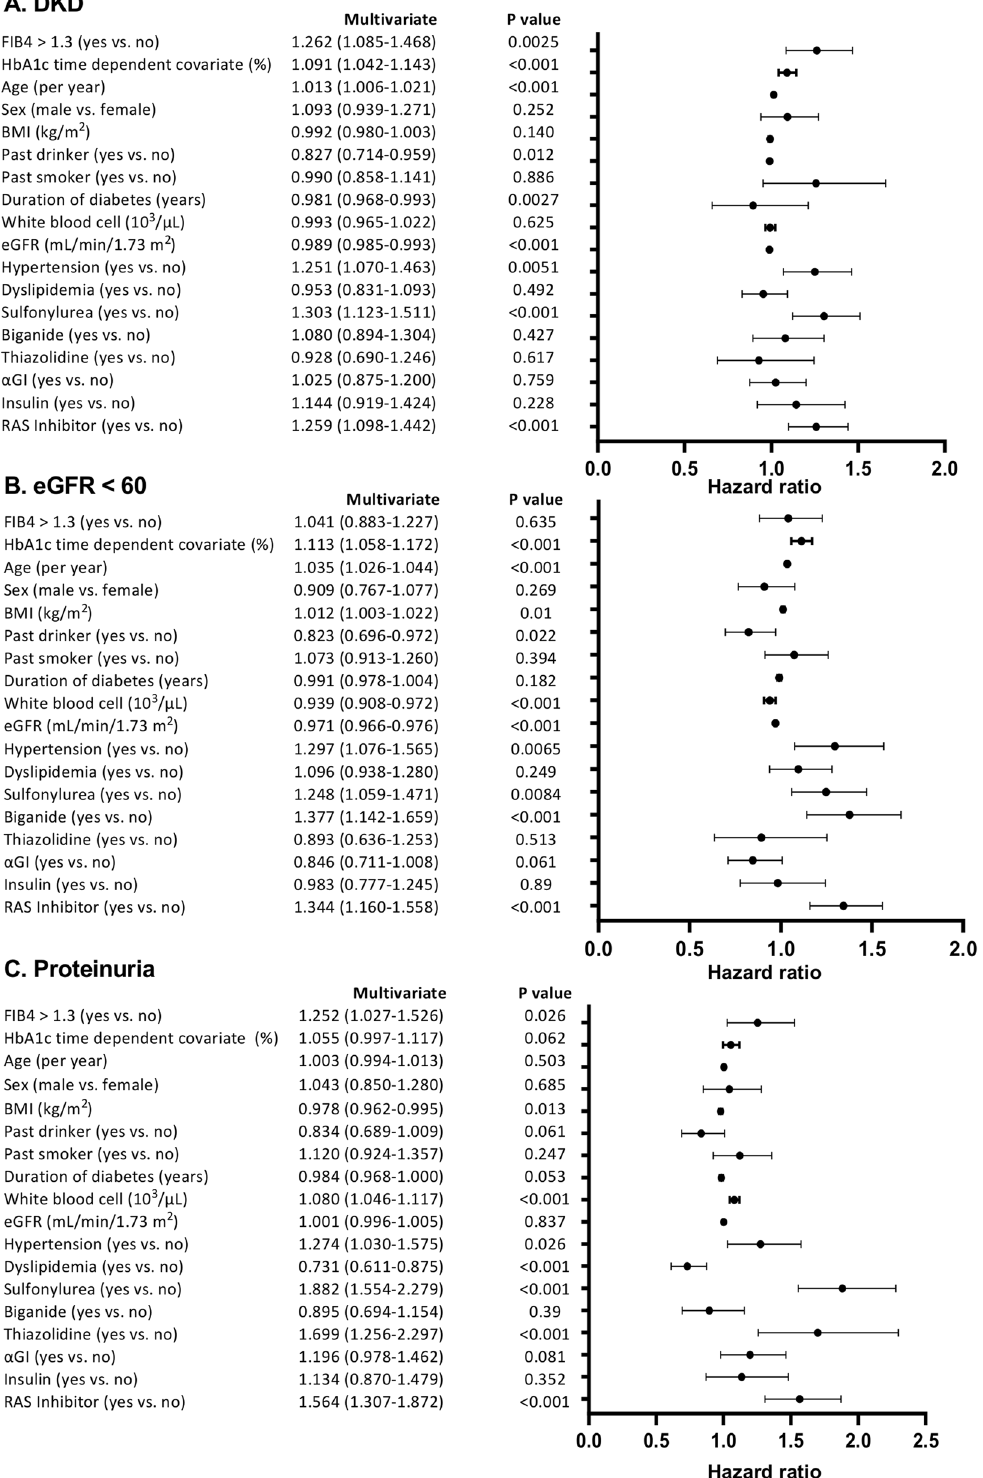
Figure 4. Cox proportional hazard ratios of FIB4 index > 1.3 for the development of ( A ) diabetic kidney disease (DKD: eGFR < 60 mL/min/1.73 m 2 or proteinuria), ( B ) eGFR < 60 mL/min/1.73 m 2 , and ( C ) proteinuria in type 2 diabetic patients. Cox proportional hazard models were adjusted for age, sex, BMI, a HbA1c time dependent covariate, baseline eGFR, smoking and drinking status (current or past), comorbidities (hypertension, dyslipidemia) and anti-diabetic and anti-hypertensive medications. 95% CI 95% confidence interval. N =